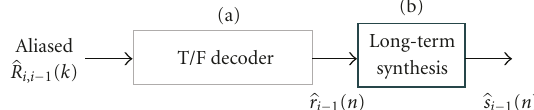
Figure 5: Decoder block diagram of the proposed algorithm.